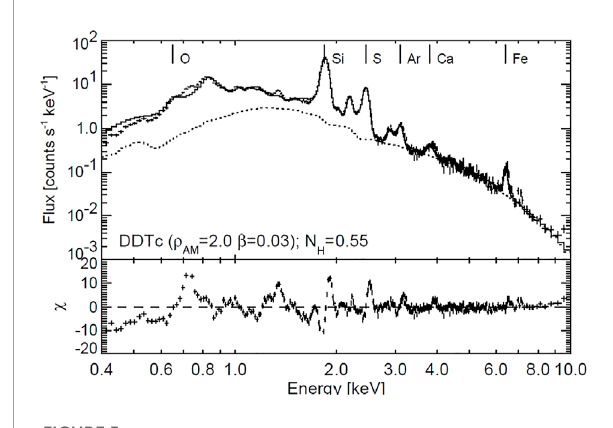
FIGURE 5 Comparison between the emission of the ejecta from a delayed detonation model ( Figure 7 of Badenes et al., 2006) and the spatially integrated spectrum of region B. Courtesy of C. Badenes. © AAS. Reproduced wih